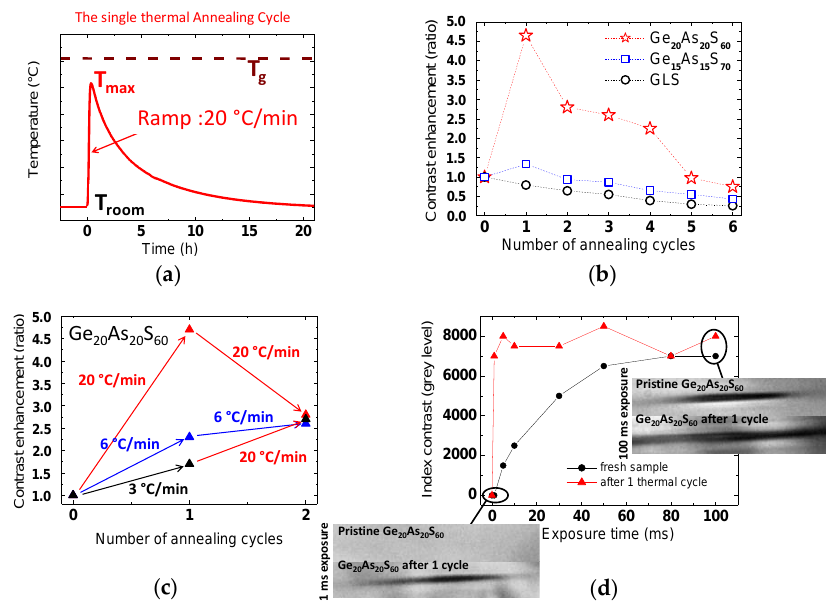
Figure 6. ( a ) Temperature vs. time behavior during the single short thermal cycle applied to ChG samples as measured at the center of the oven. The peak temperature T max and the glass transition temperature T g corresponding to a specific sample are indicated in the text; ( b ) Variation of the laser-induced relative positive index contrast in Ge 20 As 20 S 60 (pulse energy 30 nJ, pulse duration 150 fs, red stars), in Ge 15 As 15 S 70 (pulse energy 40 nJ, pulse duration 150 fs, blue squares), and in GLS (pulse energy 400 nJ, pulse duration 150 fs, dark circles) as a function of the number of annealing cycles; ( c ) Enhancement of the ultrafast laser-induced index contrast in Ge 20 As 20 S 60 during the two first annealing cycles (T max = 250 ◦ C), for three values of the heating rate: 3 (dark arrows), 6 (blue arrows), and 20 ◦ C/min (red arrows); ( d ) Type I index changes induced by a 30 nJ, 150 fs laser beam focused into the Ge 20 As 20 S 60 sample before (dark circles) and after (red triangles) the first thermal annealing cycle (heating ramp: 20 ◦ C/min, T max = 250 ◦ C). The insets correspond to the cases of low laser exposure time (1 ms laser exposure time @ 100 kHz, inset bottom-left) and high laser exposure time (100 ms laser exposure time @ 100 kHz, inset on